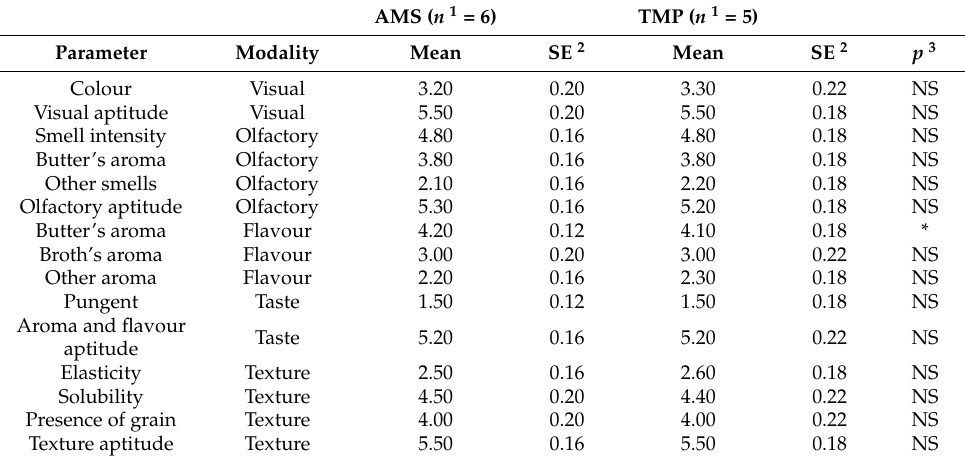
Table 6. The least square means of sensory analysis parameters of the Parmigiano Reggiano ripened for 15 months obtained from herd milk milked with automatic milking system (AMS) and with traditional milking parlor